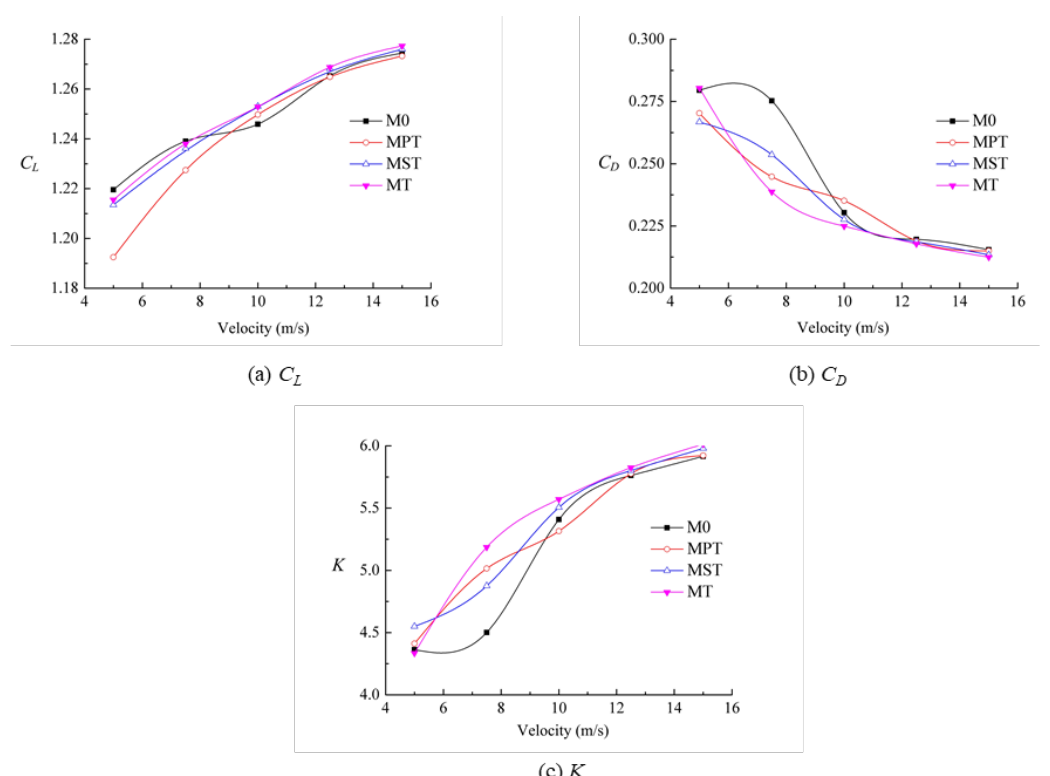
Figure 7. Energy performance of foil for different configurations.